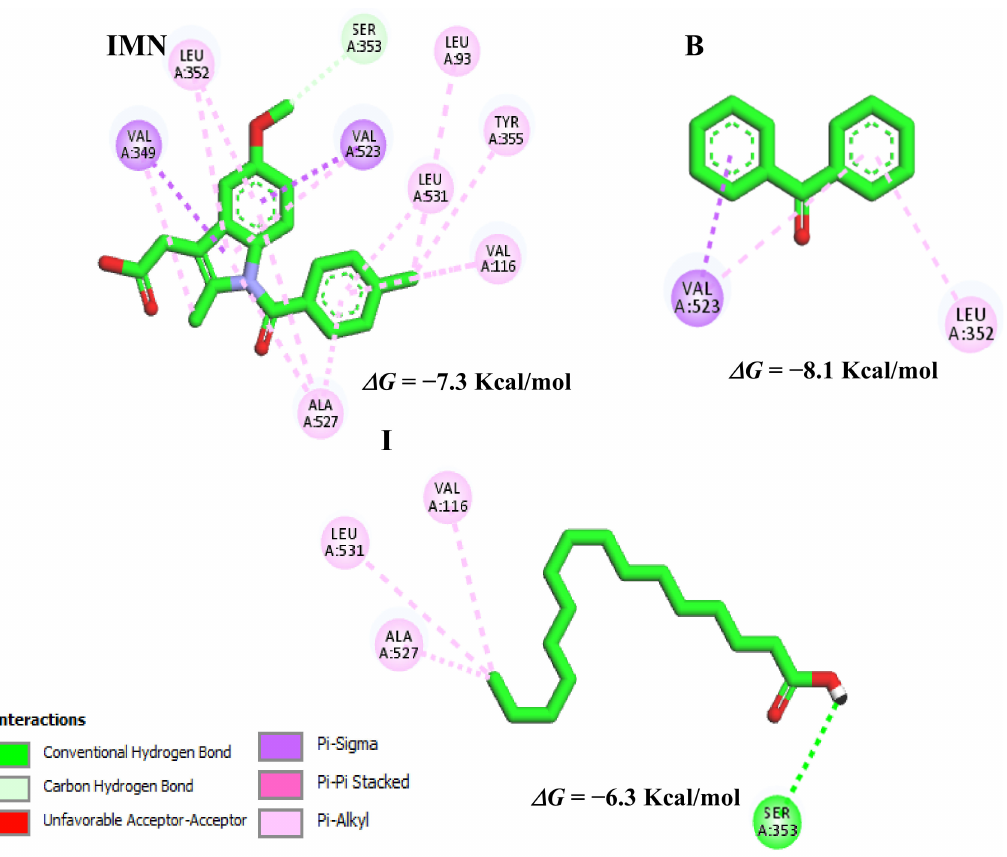
Figure 11. Interactions of the controls, RCX, CEL, IMN, and the potential inhibitors B and I with the COX-2 binding site (PDB ID: 5KIR).